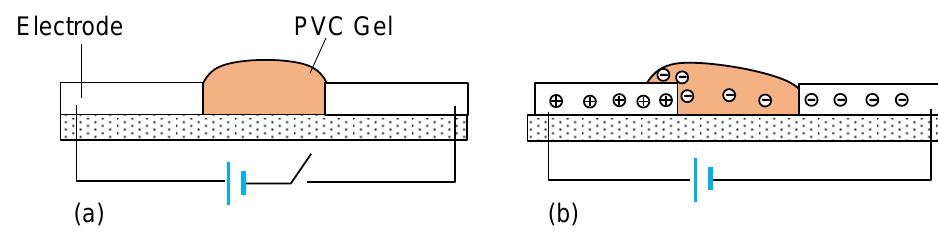
Figure 7. Mechanism for deforming a PVC gel sandwiched between two stripe electrodes: ( a ) voltage- off state and ( b ) voltage-on state.